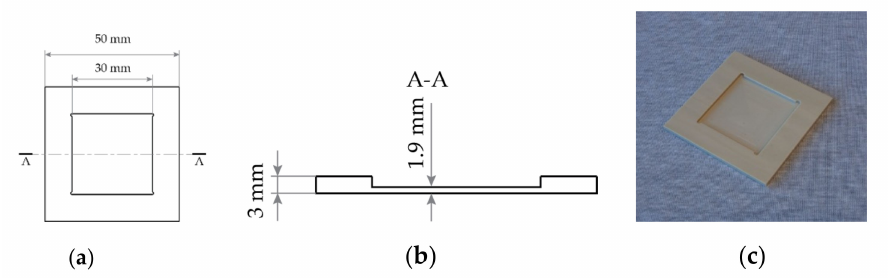
Figure 4. Technical drawing of the lithography sample mount. ( a ) Top-down view. ( b ) Cross-section through line A-A in ( a ), showing the geometry of the center of the mount. ( c ) Photograph of the lithography sample